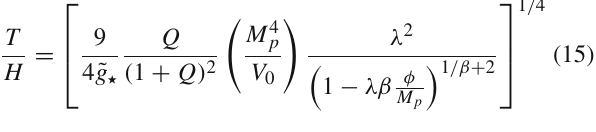
curves varying with Q (cid:10) . The dashed lines represent the weak dissipa- tion regime, while the solid lines represent the strong regime; the dotted lines correspond to a regime where T / H < 1. We have set N (cid:10) =